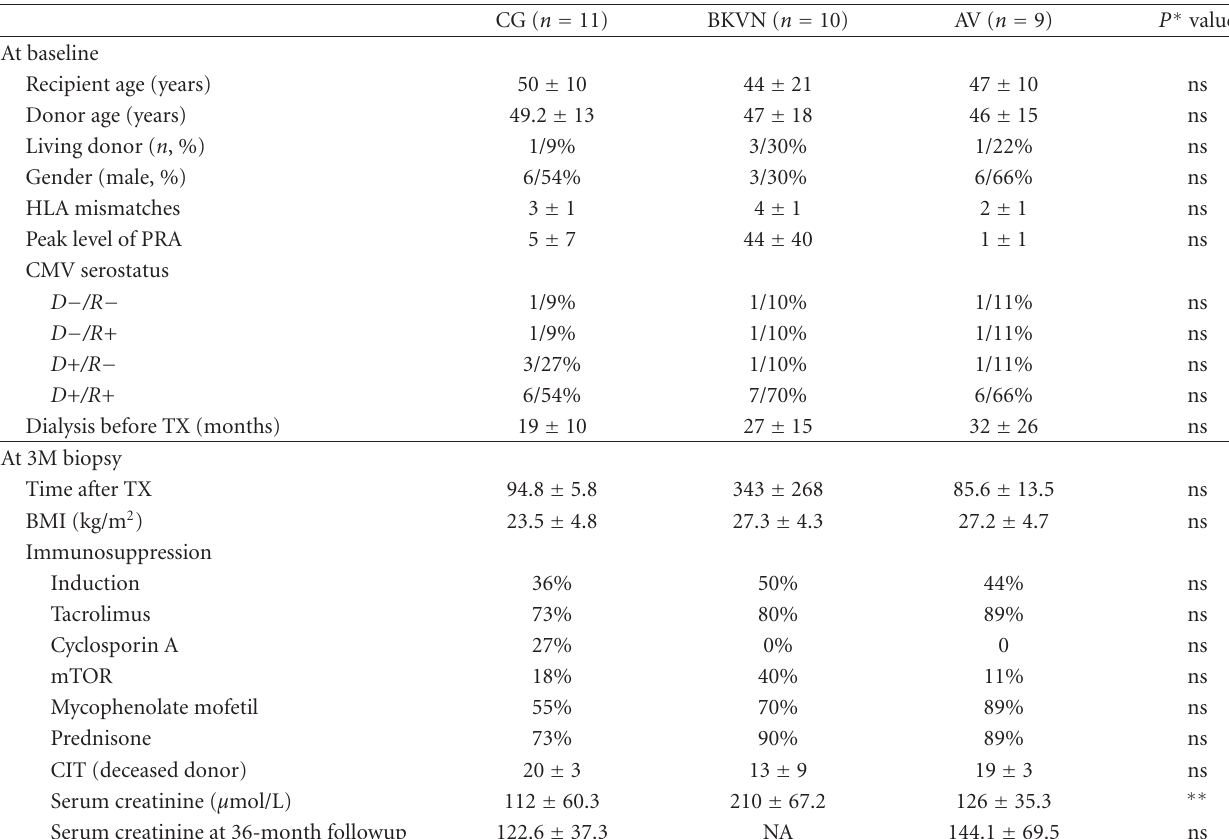
Table 1: Demographics and transplant related